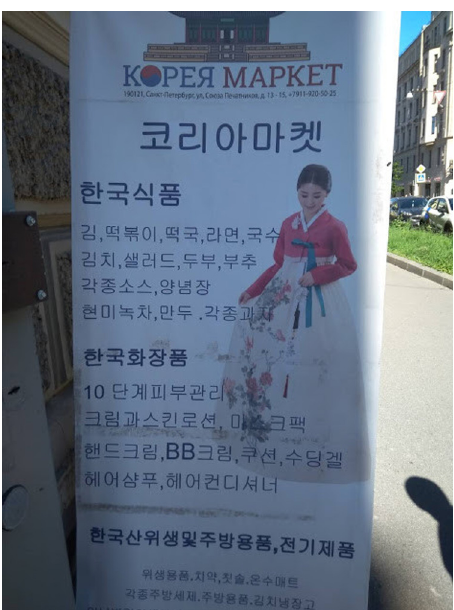
Figure 4: An advertisement of the shop specialized in Korean products. Soyuza Pechatnikov str., St. Petersburg, 2019, LinguaSnapp